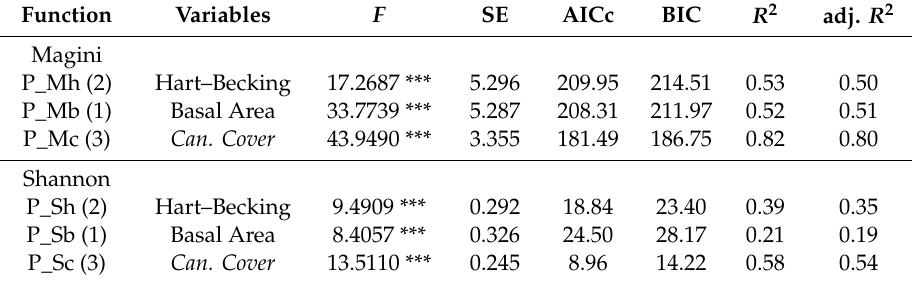
Table 4. Description of the univariate polynomial functions shown in Figure 2, relating three chosen overstory variables (Hart–Becking, Basal Area and Canopy Cover) with the Magini and Shannon indices. The first column identifies the model and shows the order of the polynomial in brackets. The table shows the F statistic, the standard error of residuals, and the values of the second-order Akaike information criterion, the Bayesian information criterion, the R 2 , and the adjusted R 2 . Test significance: *** p <